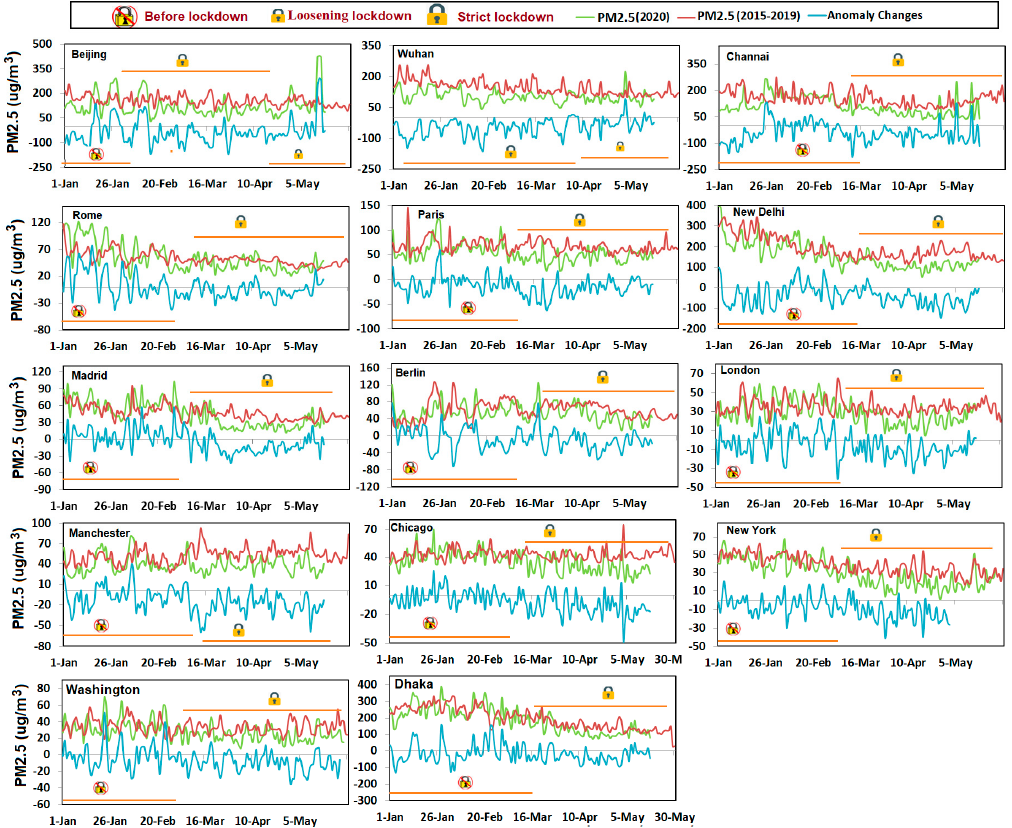
Figure 10. Daily mean dataset of PM2.5 and its anomaly changes over different major cities in 2020 against the baseline (the averaged value of PM2.5 for 2015–2019). Remote Sens. 2020 , 12 , x FOR PEER REVIEW 17 of 26